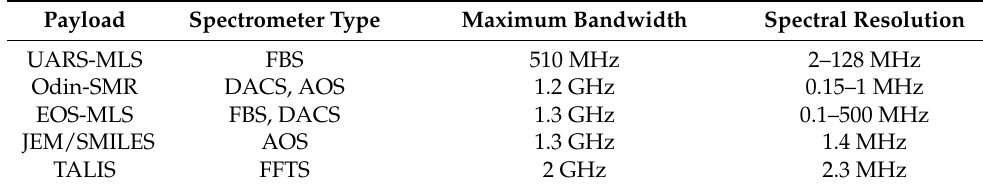
Table 2. The parameter comparison of FFTS in TALIS with the spectrometers in other MLSs.